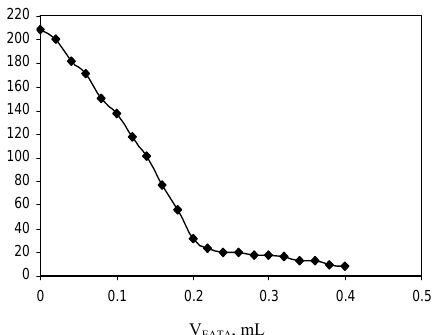
Figure 5. Potential titration curve of 20.0 mL from a 1.0 × 10 -4 M Tb 3+ solution with 1.0 × 10 -2 M of EDTA